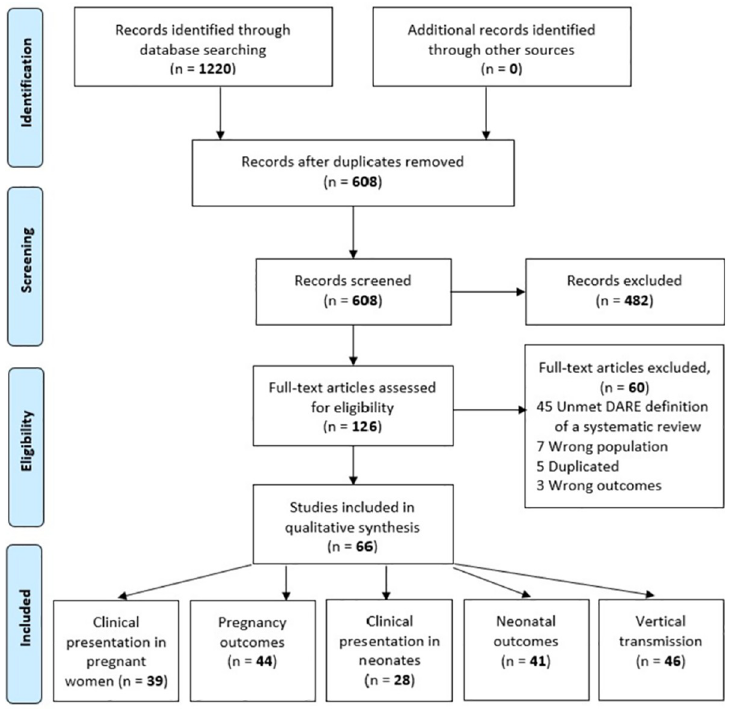
Fig 1. Study flow